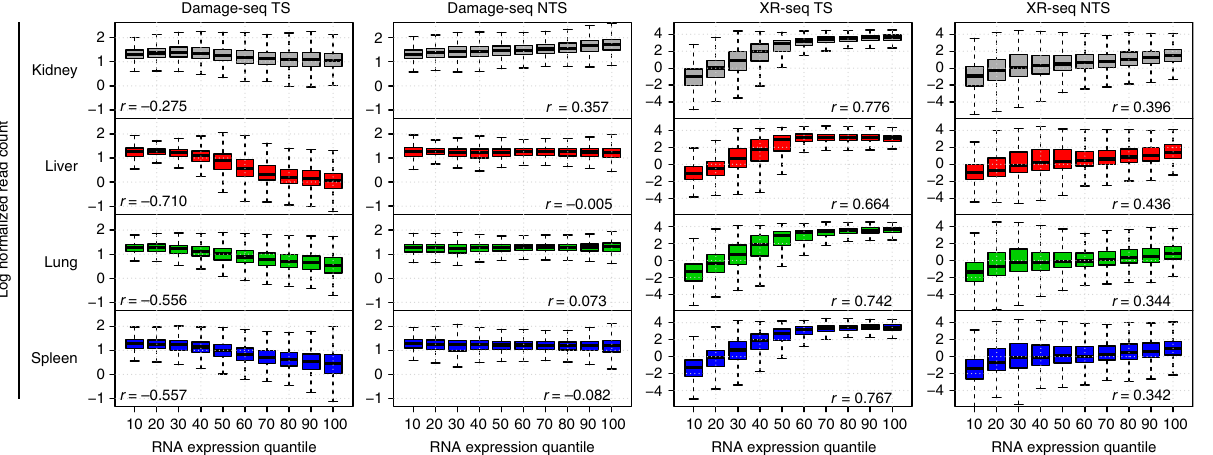
Fig. 3 Effect of transcription on cisplatin-induced damage formation and repair. Genes are grouped based on their gene expression quantiles ( x -axis) in the cisplatin-treated group. Log normalized read counts for DNA damage and repair ( y -axis) are separated by strands and averaged between replicates. Spearman correlation coef fi cients are included in each panel. TCR increases with gene expression and removes damage in the TS strand; GR also increases with gene expression, but at a lower rate